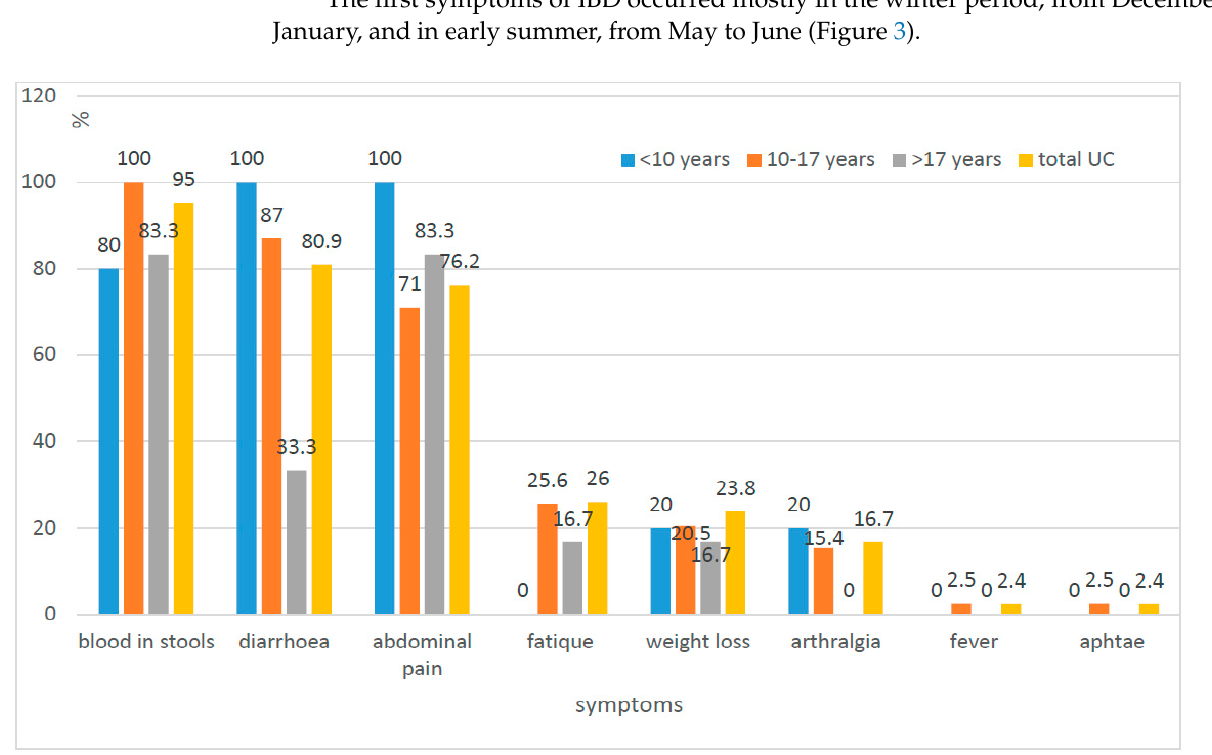
Figure 4. Seasonality of inflammatory bowel disease in children: UC—ulcerative colitis; CD—Crohn’s disease; IBD—in- flammatory bowel disease.